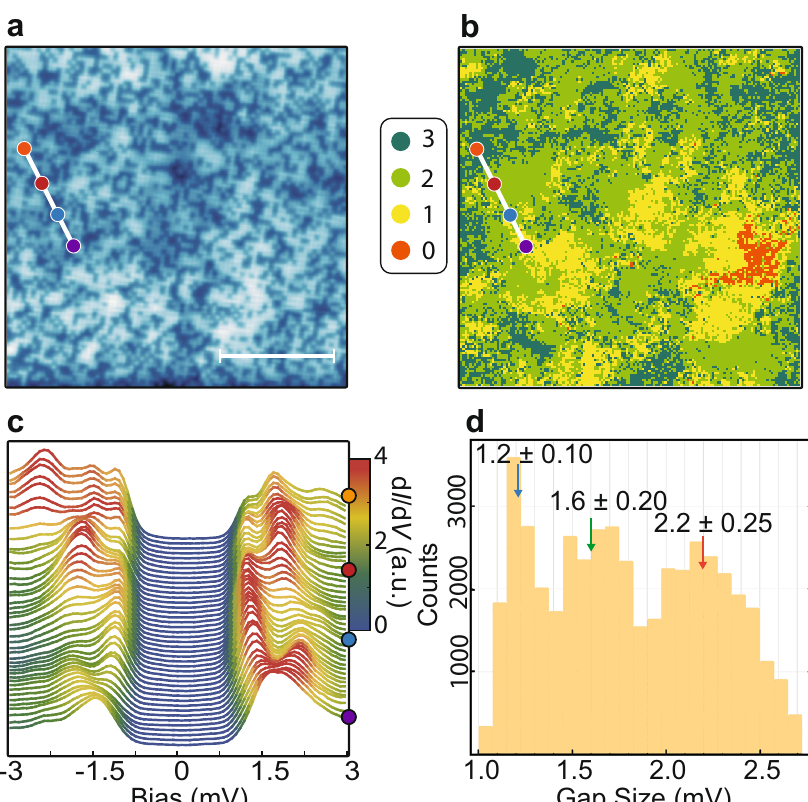
Fig. 2 Statistical analysis of superconducting gaps on a half-imbedded Fe(Se,Te) island. a Topography in a 30 nm × 30 nm fi eld of view on Fe(Se,Te), where a dI/dV map was taken at 300 mK. Scale bar is 10 nm. b Gap map, in the same area as a , describing the spatial distribution of the quantity of superconducting gaps. Orange, yellow, light green, and dark green colors indicate no gap, one gap, two gaps, or three gaps were found at each pixel, respectively. The gap values at each pixel were obtained through a multipeak- fi nding algorithm. c , Waterfall plot of dI/dV spectra obtained along the white line from the orange dot (top) to purple dot (bottom) as shown in b . d Histogram of the gap values in the overall region which shows three peaks with the mean gap values as 1.2, 1.6, and 2.2